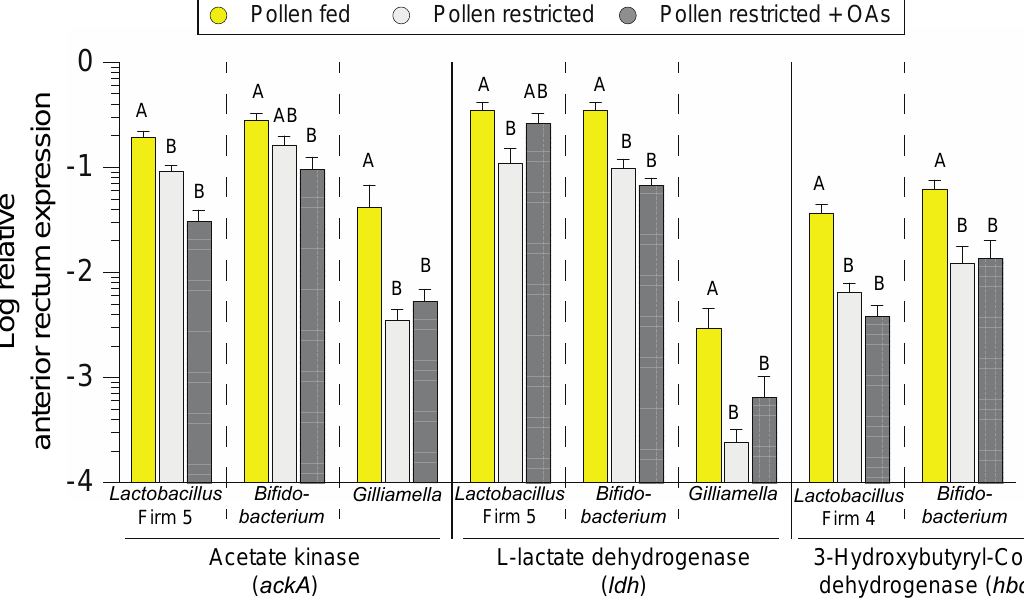
Figure 4. Expression of bacterial fermentative enzyme gene transcripts in the anterior rectum of honey bees subjected to different diet treatments ( n = 16–19 cages). Error bars represent standard error (SE). Different letters indicate Tukey HSD P < 0.05.